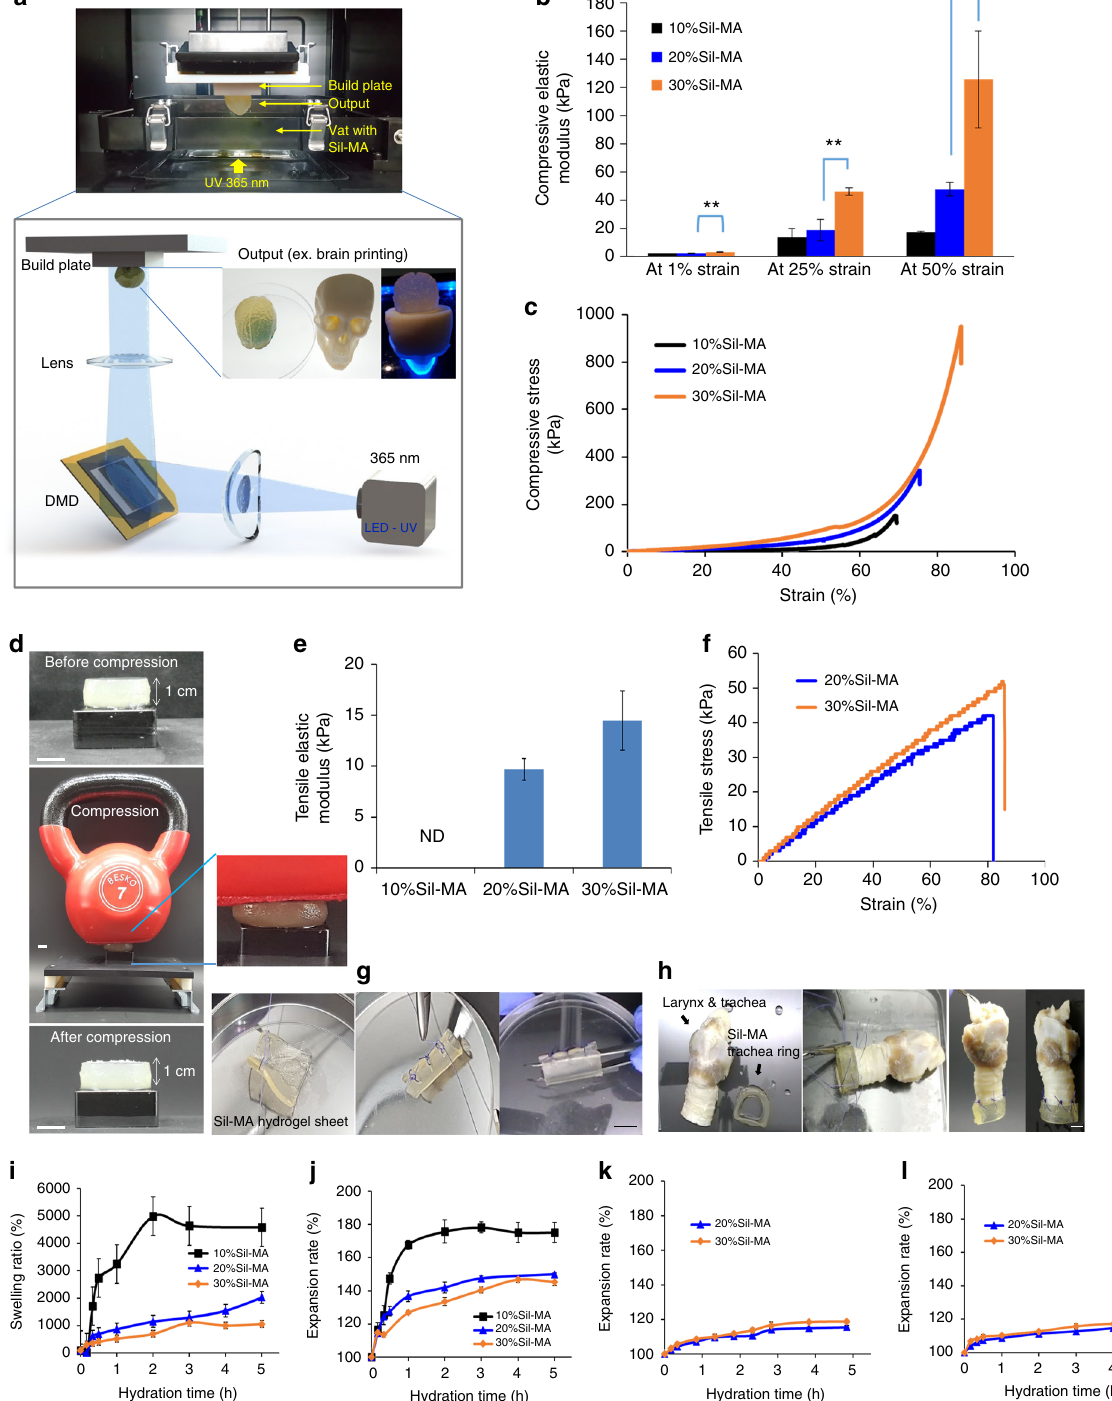
Fig. 3 Physical properties of Sil-MA hydrogel. a Schematic diagram of DLP bioprinting procedure using Sil-MA. Sil-MA-added LAP was printed in a layer- by-layer style with DLP printer. Herein, the desired pattern was designed through CAD software and was sliced to a layer fi le before transferring it to the DLP system. DMD digital micromirror device. b – d Compression test for Sil-MA hydrogel with varied Sil-MA contents. b Compressive elastic modulus of Sil-MA hydrogel at different percentage strains. Signi fi cant differences are presented. * p < 0.05 and ** p < 0.005 (two-sample t -test). c Representative compressive stress – strain curve and d the Sil-MA hydrogel was compressed by a kettle bell (7 kg) for 3 min and recovered hydrogel ’ s initial shape after it was removed. e – h Tensile stress for Sil-MA hydrogel. e Tensile elastic modulus of Sil-MA hydrogel at 50% strain and f representative tensile stress – strain curve of Sil-MA hydrogel. g Suturing of folded lumen structure of 3D-printed Sil-MA membrane and h trachea end-to-end anastomosis of dog ’ s larynx and trachea using Sil-MA 3D DLP-printed hydrogel. Scale bar indicates 1 cm. i – l Swelling properties. i Water uptake of Sil-MA powder. Volume expansion rate of DLP product in j water, k medium, and l PBS (pH 7.4). Data are presented as mean ± s.d. The black line (/bar), blue line (/bar), and orange line (/bar) indicate 10%, 20%, and 30% of Sil-MA hydrogel, respectively. Each assay was conducted in